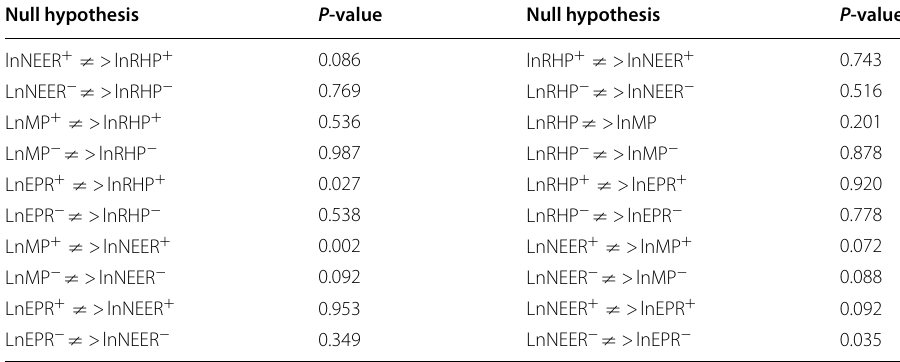
Table 7 Asymmetric causality